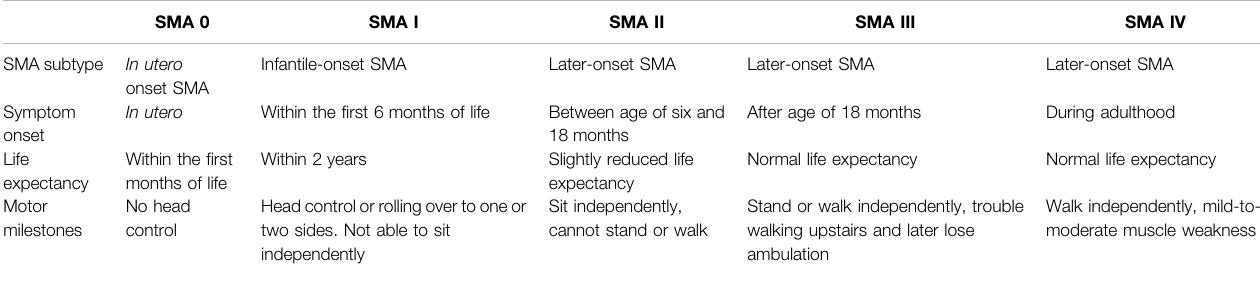
TABLE 1 | The different subcategories of SMA and their characteristics (Pearn, 1980; Munsat and Davies, 1992; Zerres and Rudnik-Schöneborn, 1995; Wijngaarde et al.,